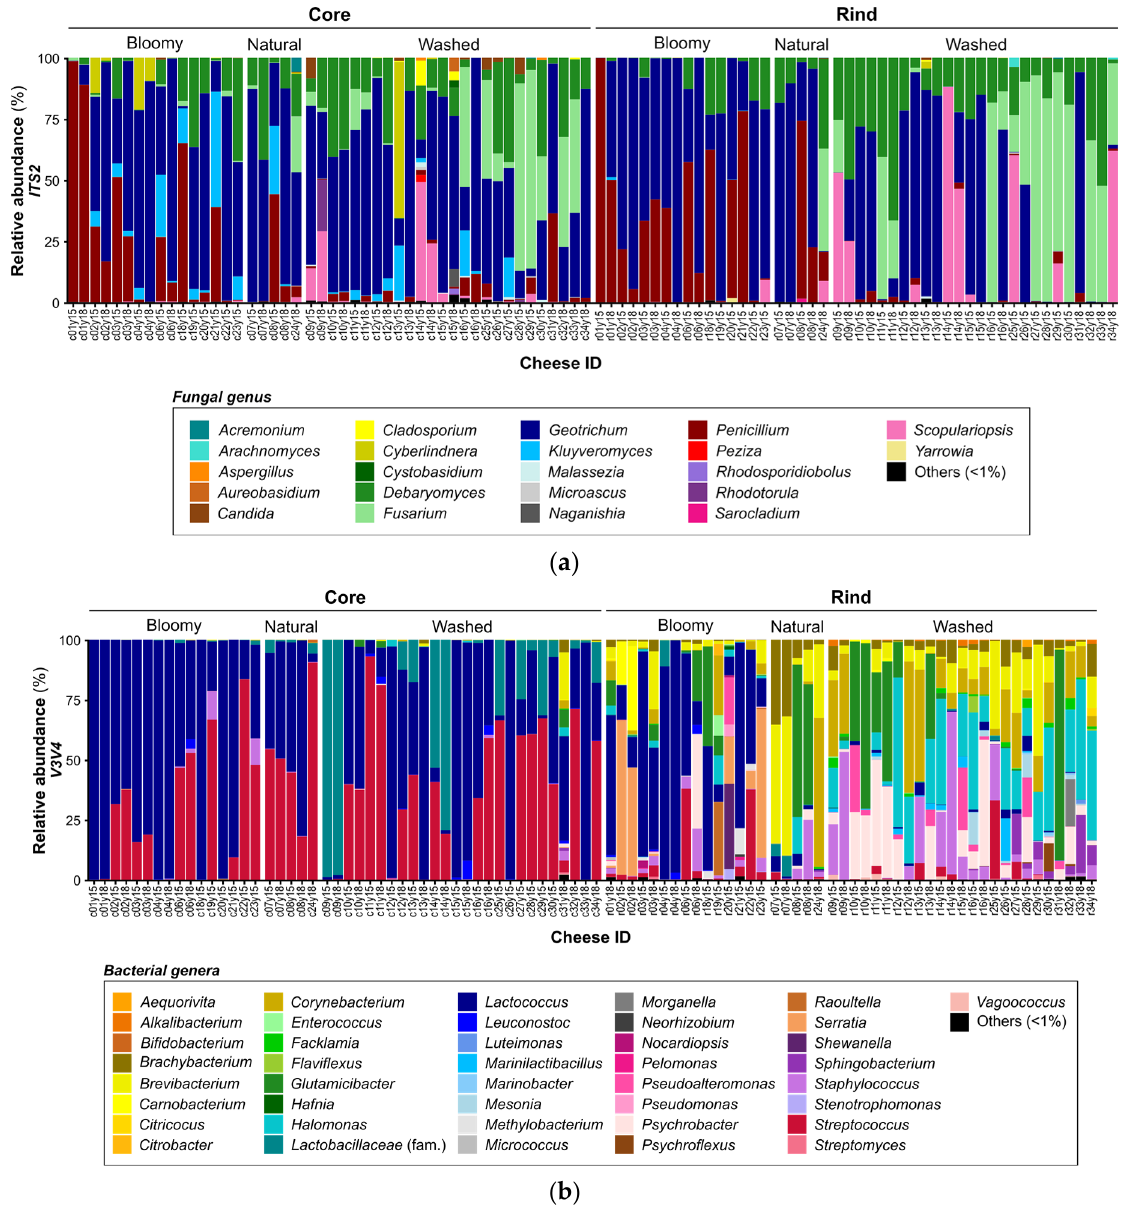
Figure 3. Comparative distribution of the most abundant genera in cheese ecosystems. Horizontal sections show different parts of the cheese according to the rind type (bloomy, natural or washed): the left row shows cheese core data, and the right row shows cheese rind data. The last number of the cheese ID refers to the year of production (2015 or 2018) for the 32 cheese varieties. ( a ) Each column shows the relative abundance of the bacterial (V3–V4) microbiota representing over 1% of the average abundance (order <1% are combined and shown in black). ( b ) Each column shows the relative abundance of the fungal (ITS2) microbiota representing over 1% of the average abundance (order <1% are combined and shown in black). Table 2. Richness and α -diversity of cheese microbiota.